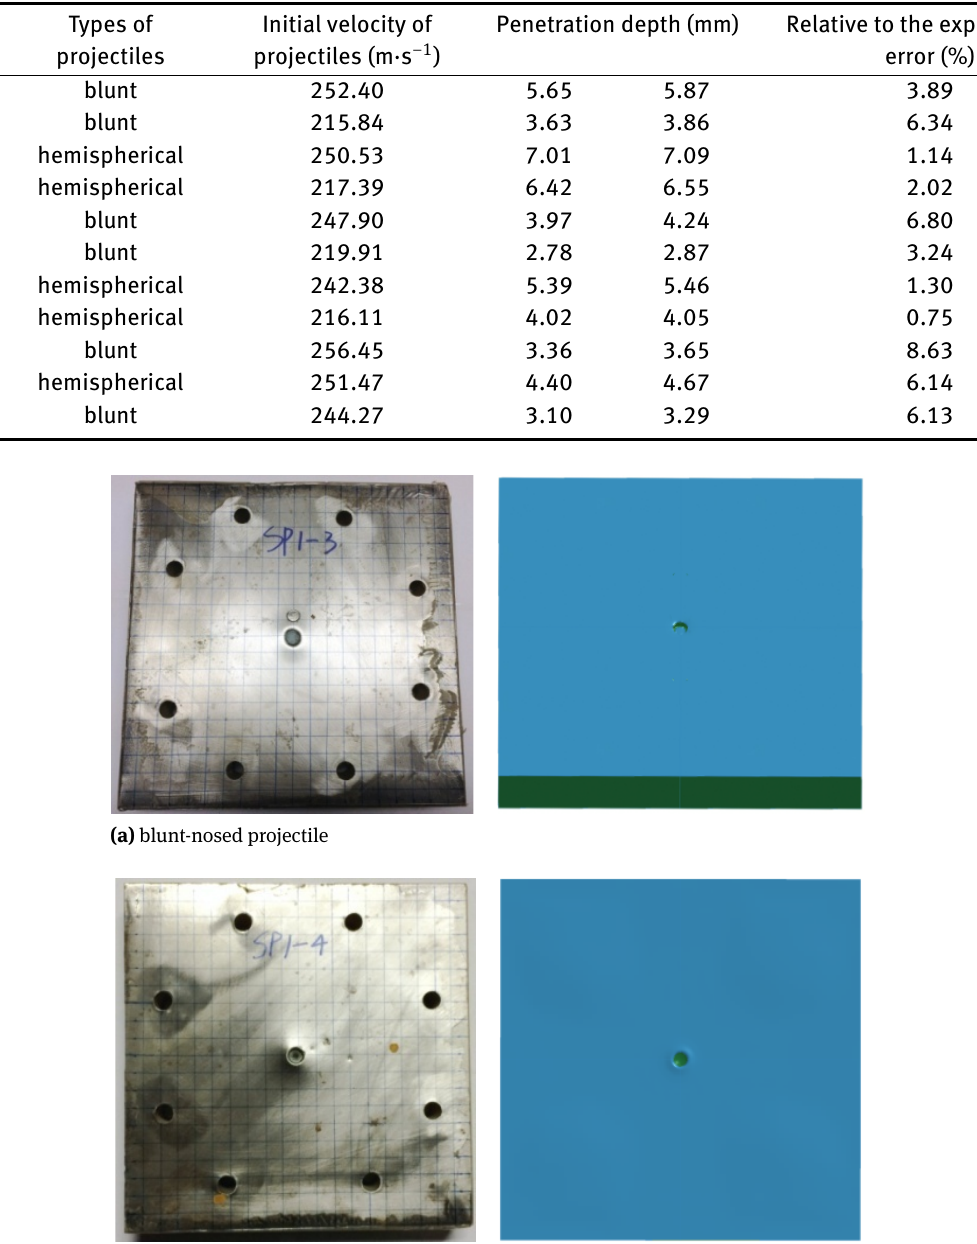
Table 5: Numerical and experimental results of sandwich plates